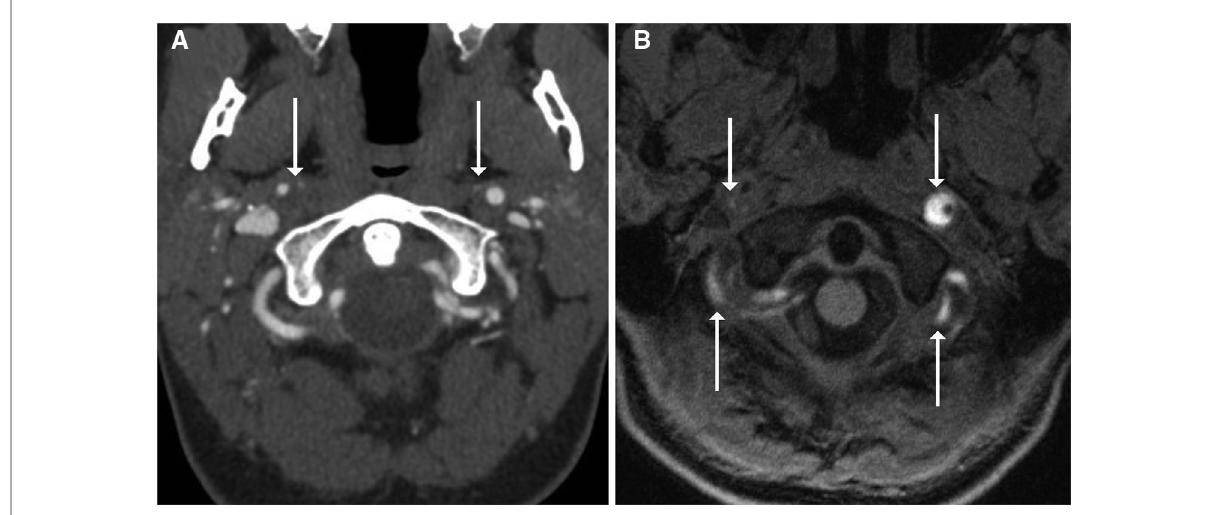
FIGURE 5 Imaging of a 28-year-old woman who presented with neck pain and headache immediately after delivering her fi rst child. CTA ( A ) showed narrowing of the right more than left cervical internal carotid arteries with suspected crescentic intramural hematomas (arrows). MRA was performed with MPRAGE ( B ), which con fi rmed bilateral internal carotid artery and vertebral artery intramural hematomas, with many areas showing crescentic T1 hyperintense signal